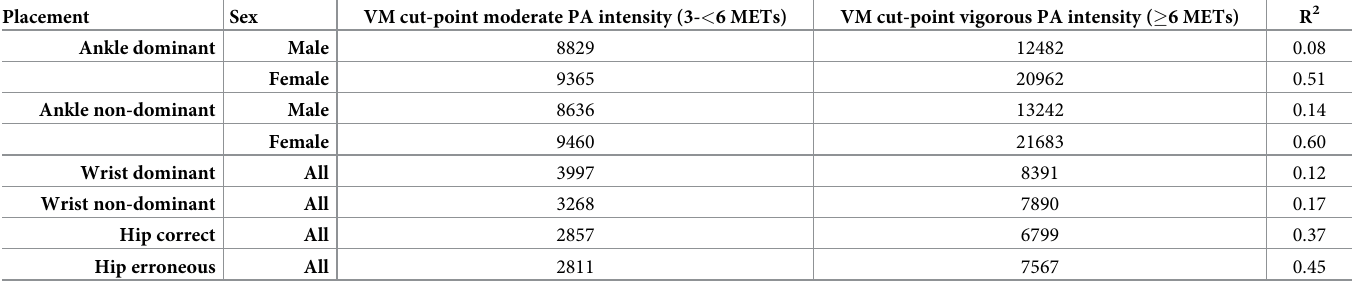
Table 2. Accelerometer cut-points for moderate and vigorous physical activity derived from treadmill experiments. Vector magnitudes of 60-sec intervals sampled at 1-sec epochs. Placement